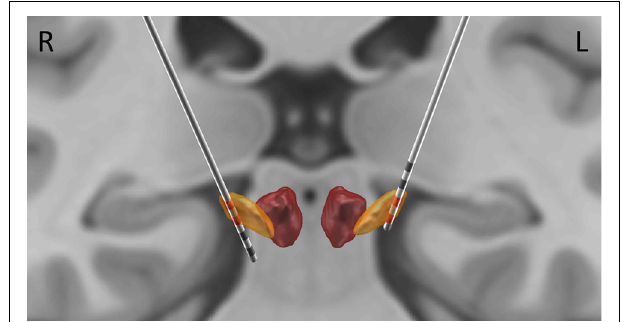
FIGURE 1 | Localization of electrode contacts. The localization was performed based on post-operative CT, coregistered to pre-operative magnetic resonance imaging (MRI). Subthalamic nucleus (STN) and the Red Nucleus are visualized based on DISTAL atlas (Ewert et al., 2018). The contacts used for bipolar derivations reported here (2, 3 on the right; 0, 1 on the left) are highlighted in red.